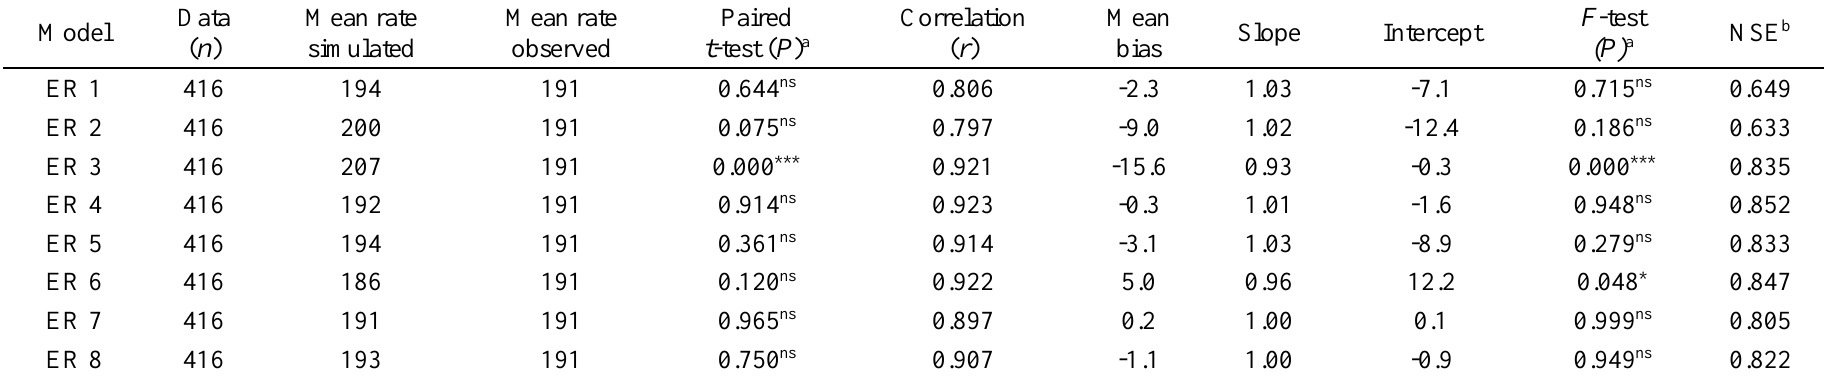
Table A1. Model performance statistics for ecosystem respiration (ER) models fitted to data from flooded (F) treatments. Model